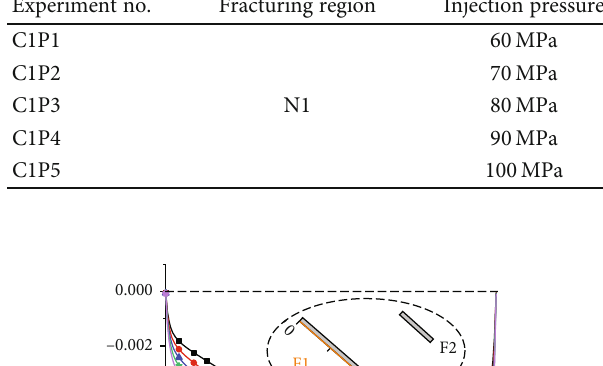
Figure 18: The fault slippage of F2 of di ff erent injection pressures (Nos.